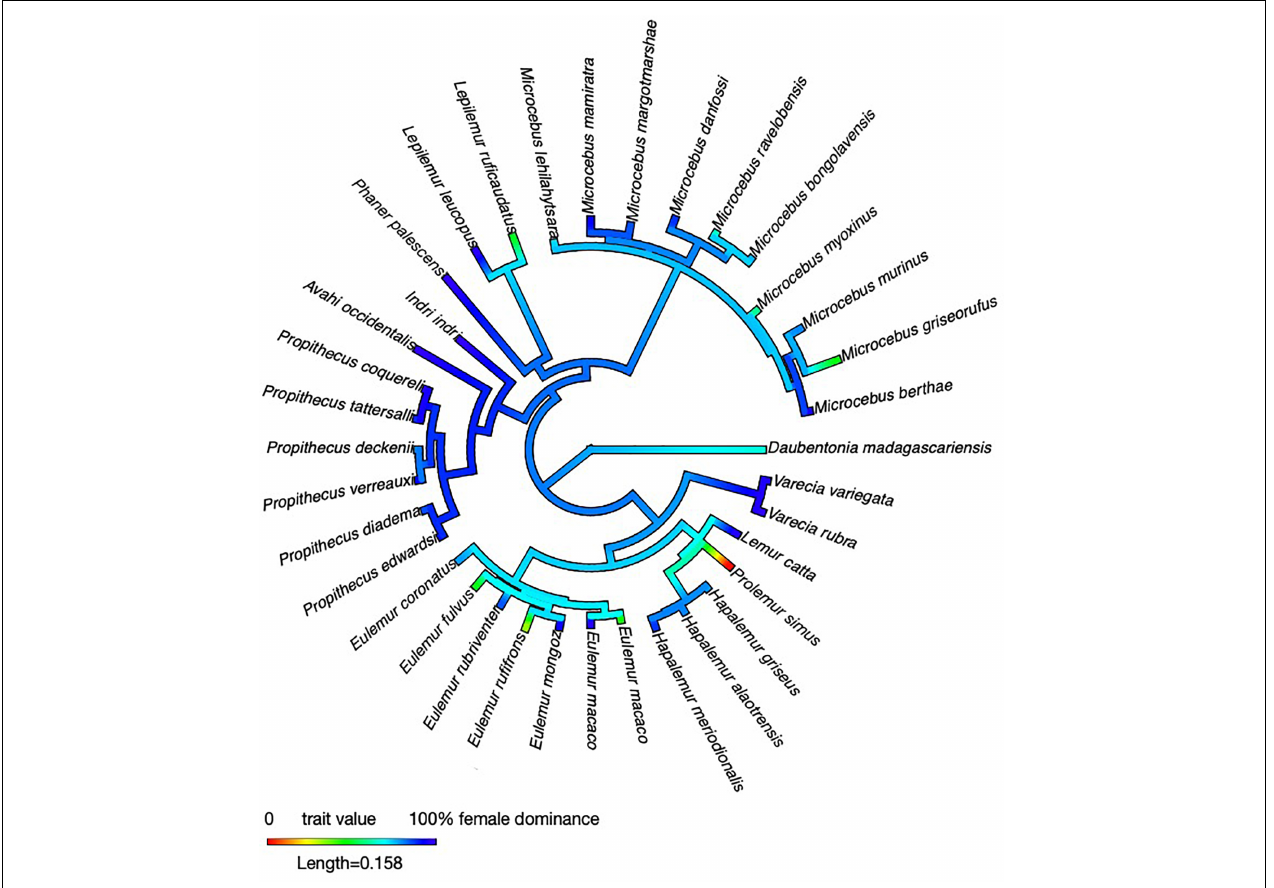
FIGURE 2 | Phylogenetic reconstruction of intersexual dominance across the Lemuriformes. We conducted an ancestral state reconstruction using the package “phytools” (Revell, 2012) in R (version 4.0.3; R Core Team, 2020). For illustrative purposes, we mapped female dominance, i.e., the percentage of conflicts won by females, on a consensus tree obtained from the 10k trees website (Arnold et al., 2010). Female dominance varies between 0 and 100%, making a formal reconstruction formally challenging, also because no obvious criteria for a discrete classification (female dominance: “yes” or “no” exist). All data were taken